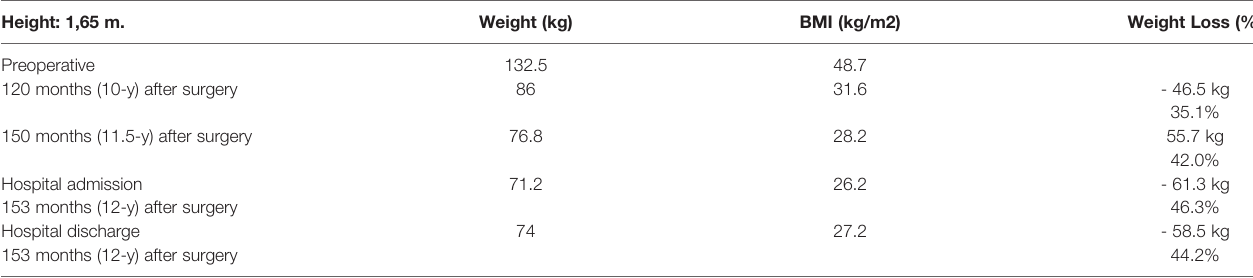
TABLE 1 | Anthropometric evaluation during the follow up. Height: 1,65